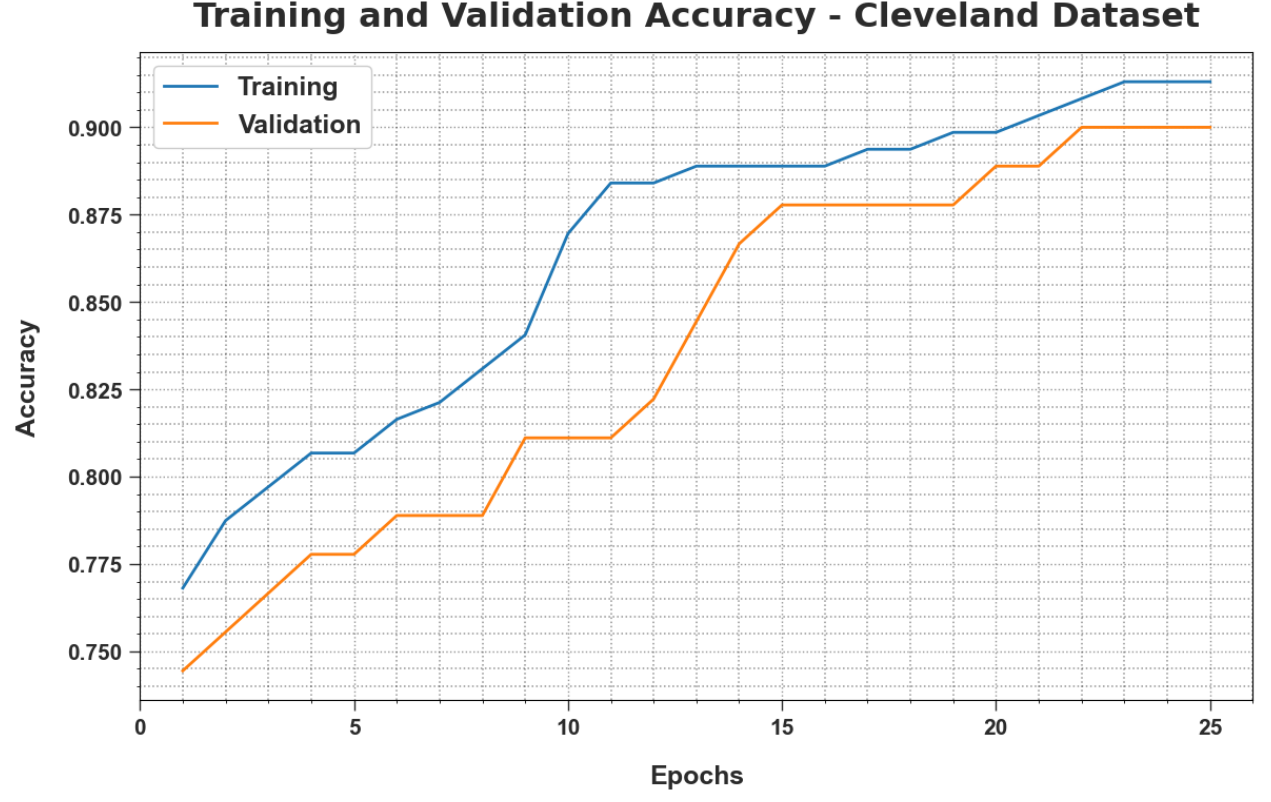
Figure 6. 𝑇𝑅 𝑎𝑐𝑐 and 𝑉𝐿 𝑎𝑐𝑐 analyse the results of the MLMDMC-ED algorithm on the Figure 6. TR acc and VL acc analyse the results of the MLMDMC-ED algorithm on the